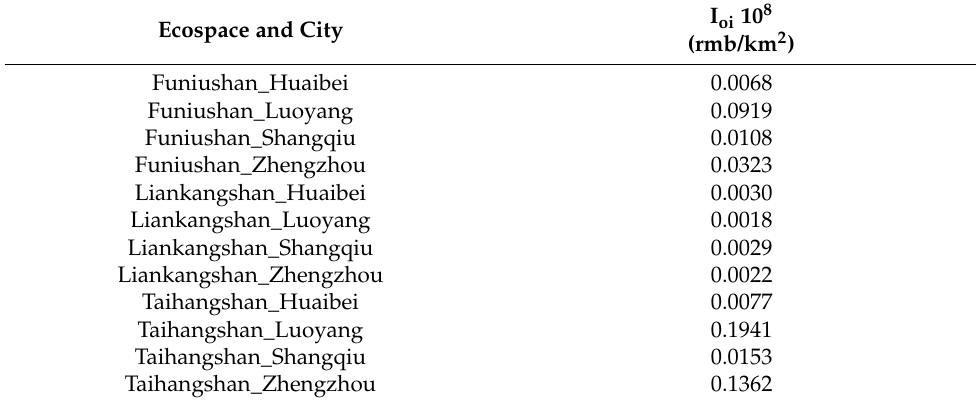
Table 8. ES intensity (I oi ) of ecospace to the cities (population center point). Ecospace and City Funiushan_Huaibei 0.0068